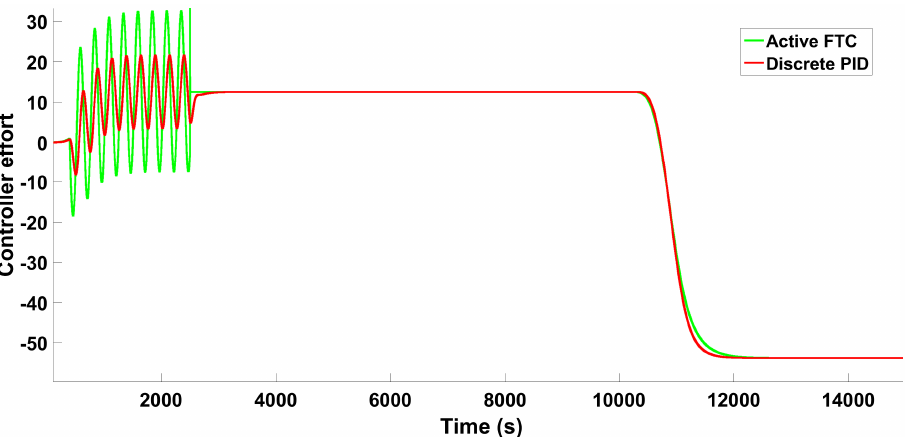
Figure 15. Scenario 1 − Sine wave-type fault: Control signals applied on the reduced model (Hammerstein −